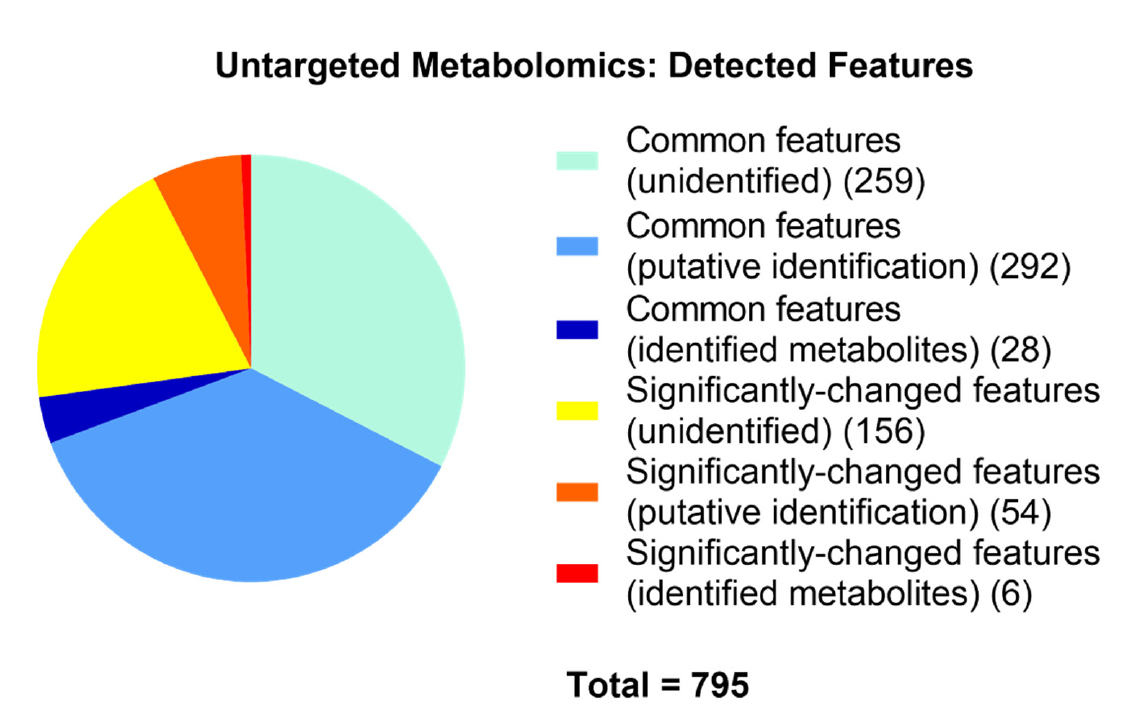
Figure 3. Detected features from base peaks, including identified and putatively-identified metabolites by untargeted metabolomics. Significant differences were determined by both t-tests with FDR corrections and having VIP values >1.